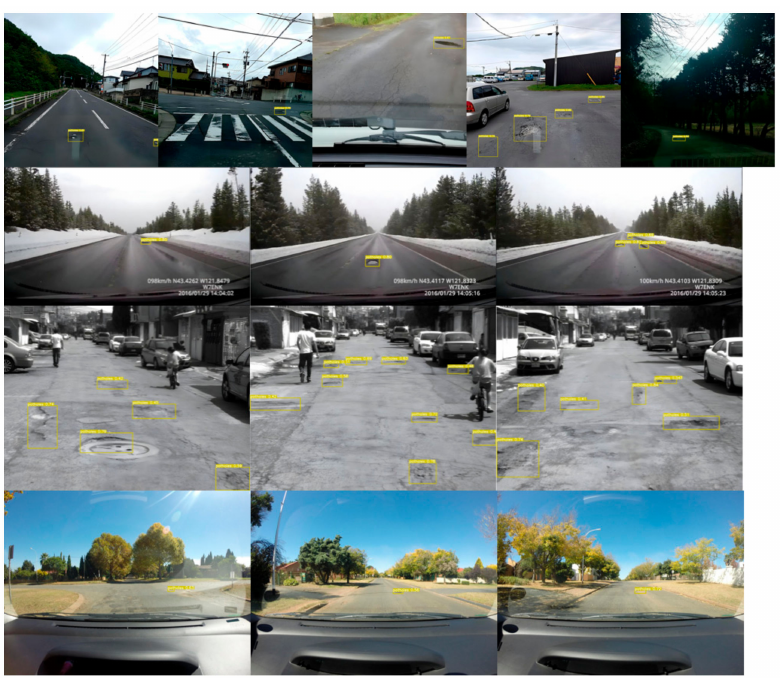
Figure 6. Detected potholes from the validation set using the ESRGAN + YOLOv5 method, with each row showing images from the different datasets.